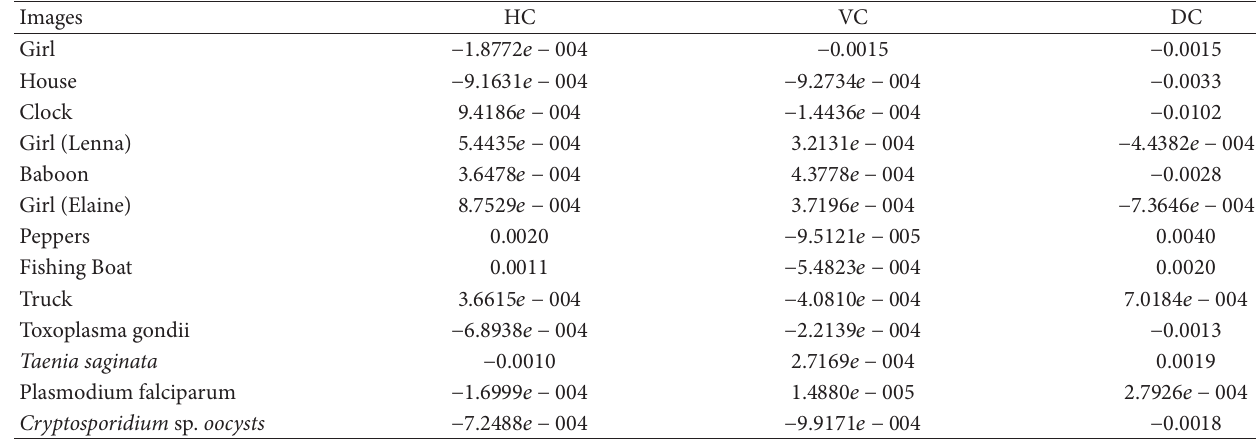
Table 4: Correlation coefficients of two adjacent pixels in original and encrypted